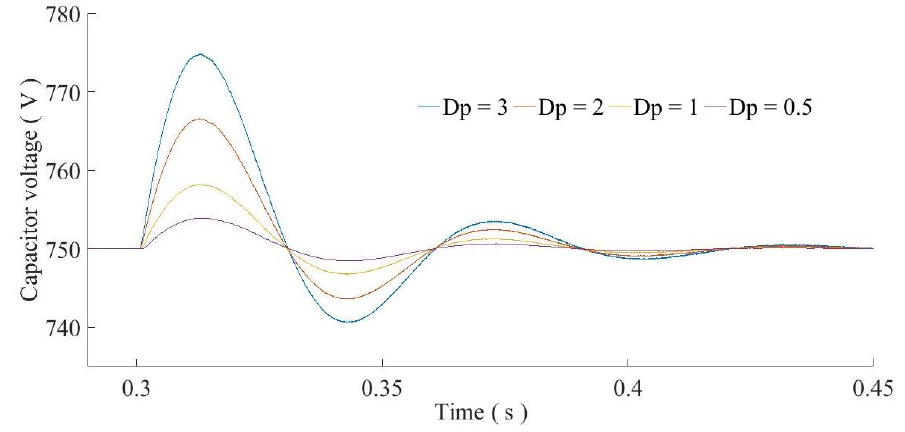
Figure 8. Influence of D p on the dynamic performance of the DDPS.